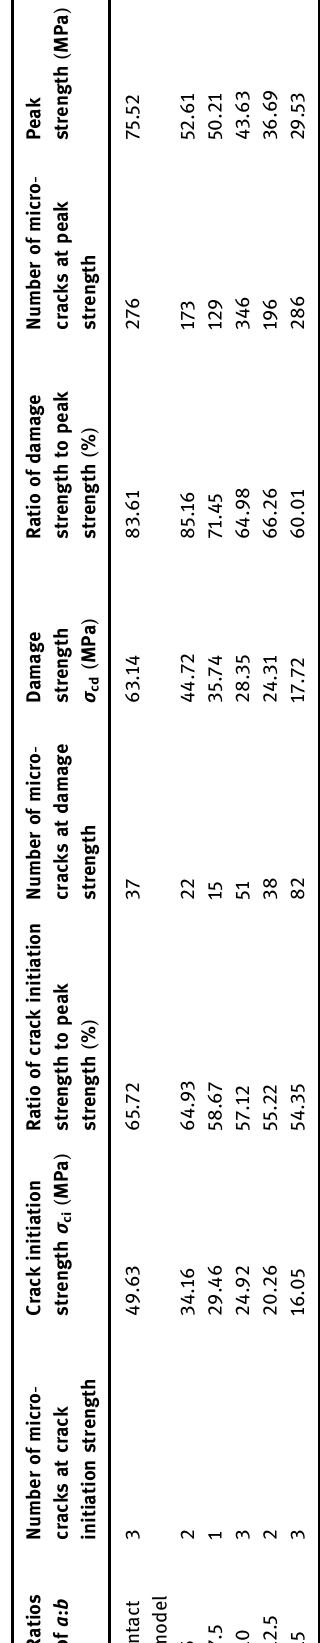
Figure 5: Mechanical model of fl at elliptical